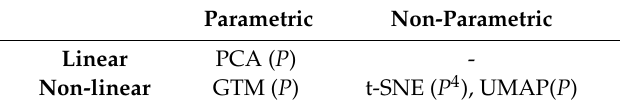
Table 1. Dimensionality reduction techniques and their respective computational e ffi